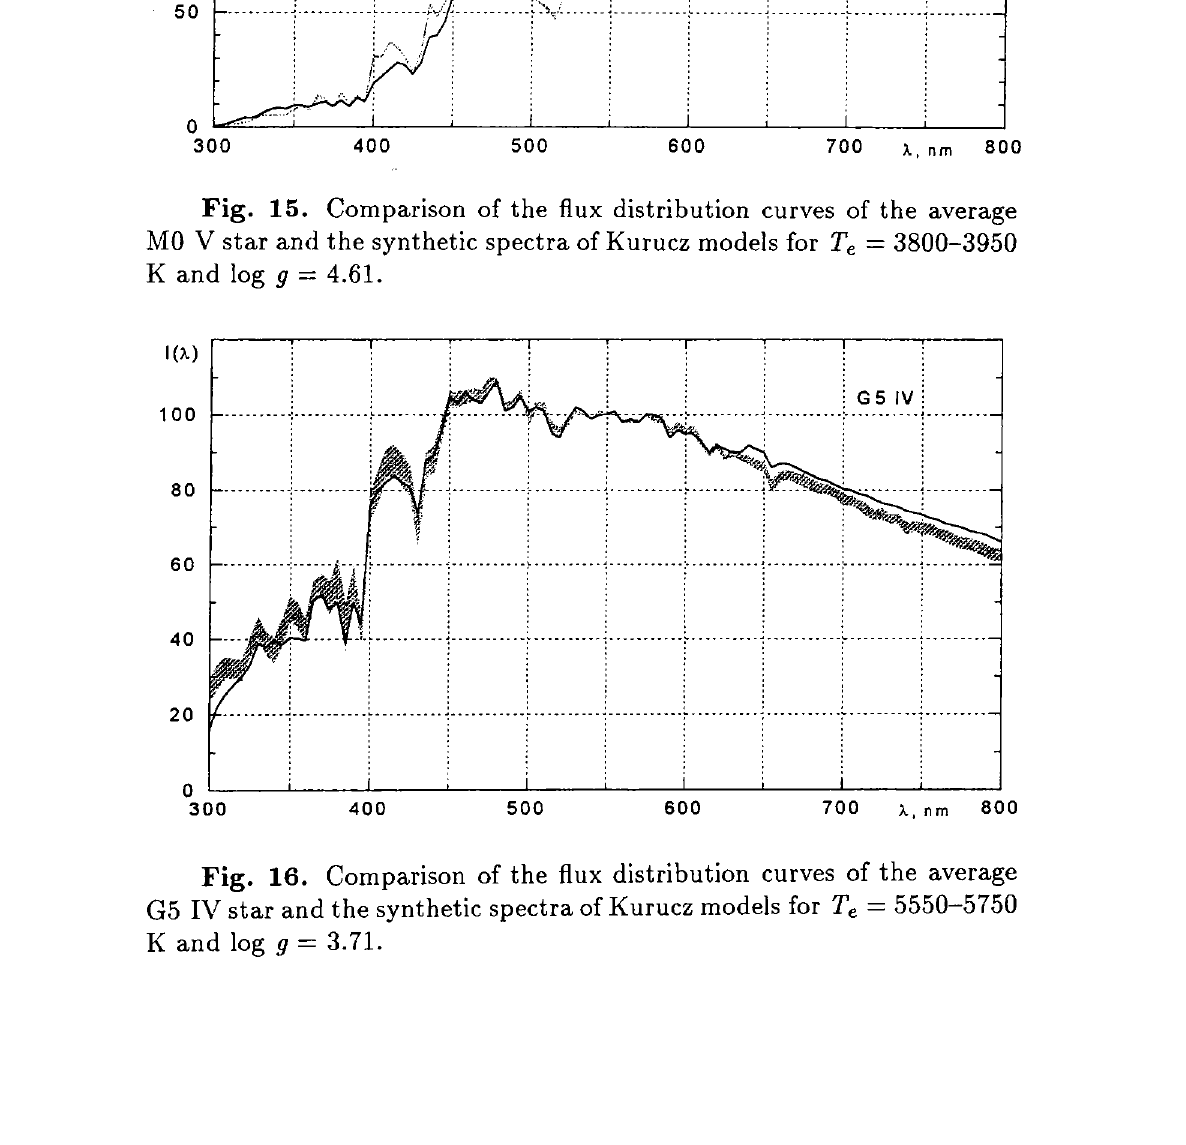
Fig. 15. Comparison of the flux distribution curves of the average M0 V star and the synthetic spectra of Kurucz models for T e = 3800-3950 K and log g = 4.61.